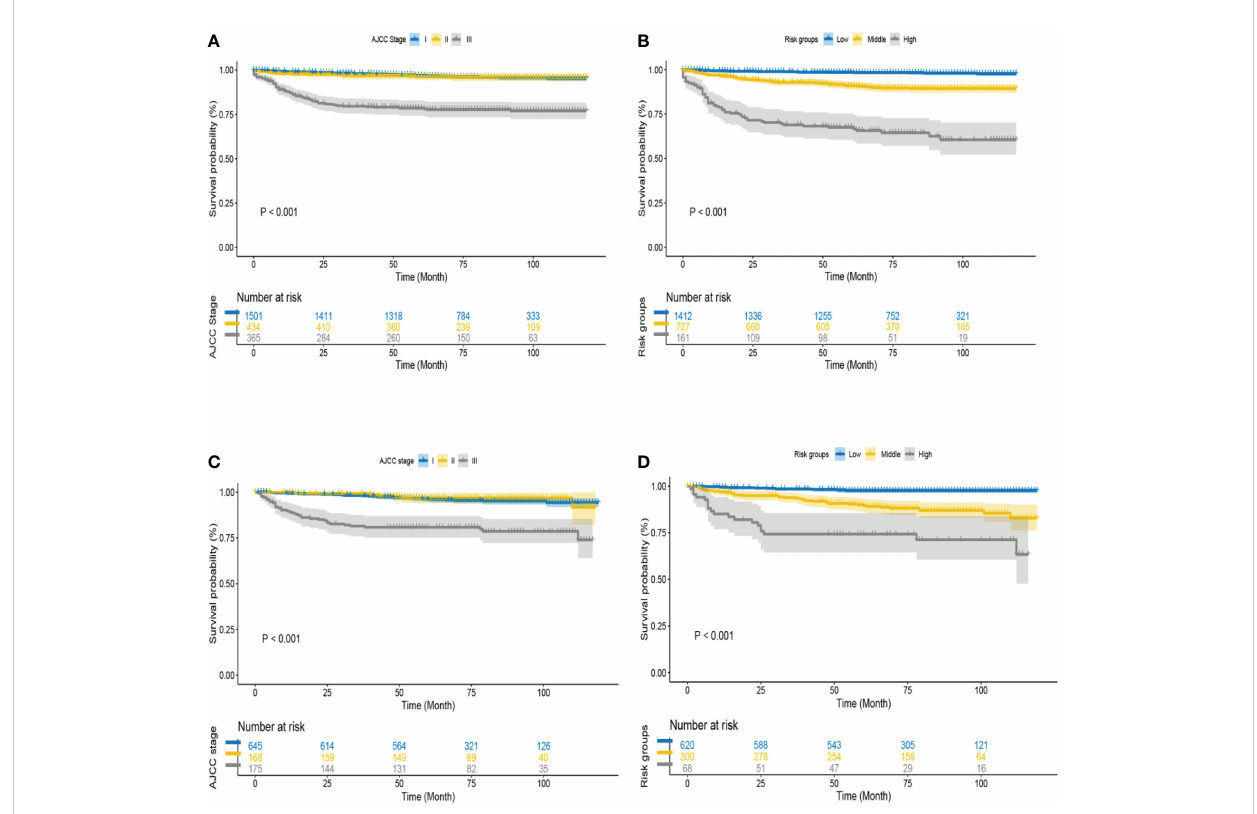
FIGURE 8 The Kaplan-Meier curve of overall survival for TGCT-LVI patients. (A) AJCC staging system and (B) a new risk strati fi cation system in the training cohort. (C) AJCC staging system and (D) a new risk strati fi cation system in the validation